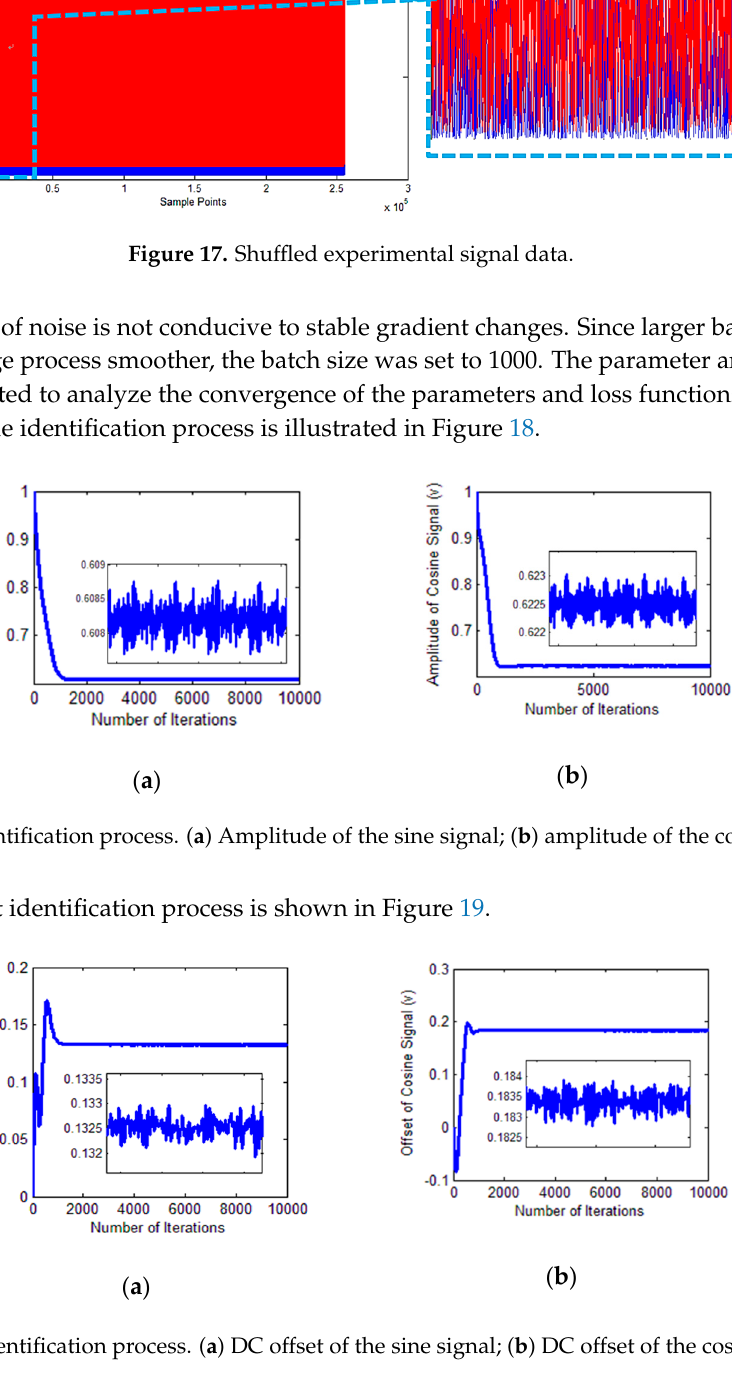
Figure 16. Signals for experiment. ( a ) Sinusoidal and cosine signals; ( b ) Lissajous figure for the output signals. signals.